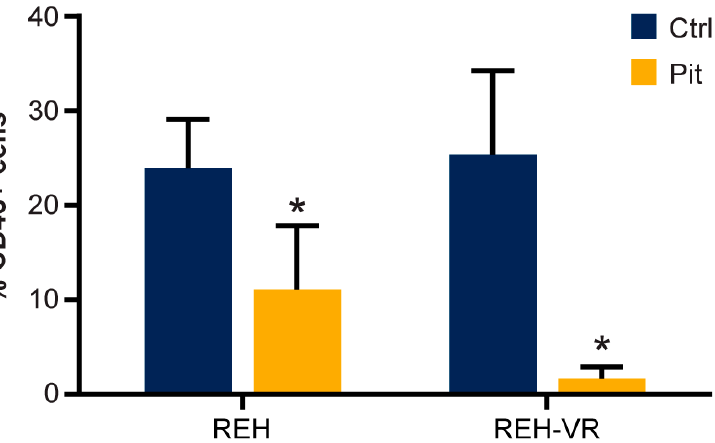
Figure 8. B-cell ALL mouse model. REH and REH-VR cells were engrafted in NSG mice. Mice were treated daily with pitavastatin (Pit, 10 mg/kg i.p.) for 4 weeks, while control mice were treated with vehicle (Ctrl). The percentage of human CD45+ ALL cells was determined in the bone marrow cells of mouse femurs. Pitavastatin significantly reduced the percentage of CD45+ cells in both parental and vincristine-resistant cells. No statistical difference was found for percent CD45+ cells between the REH and the REH-VR for vehicle control mice. Each bar represents average ± S.D., where n = 5 mice; * p < 0.05 denotes statistical significance.